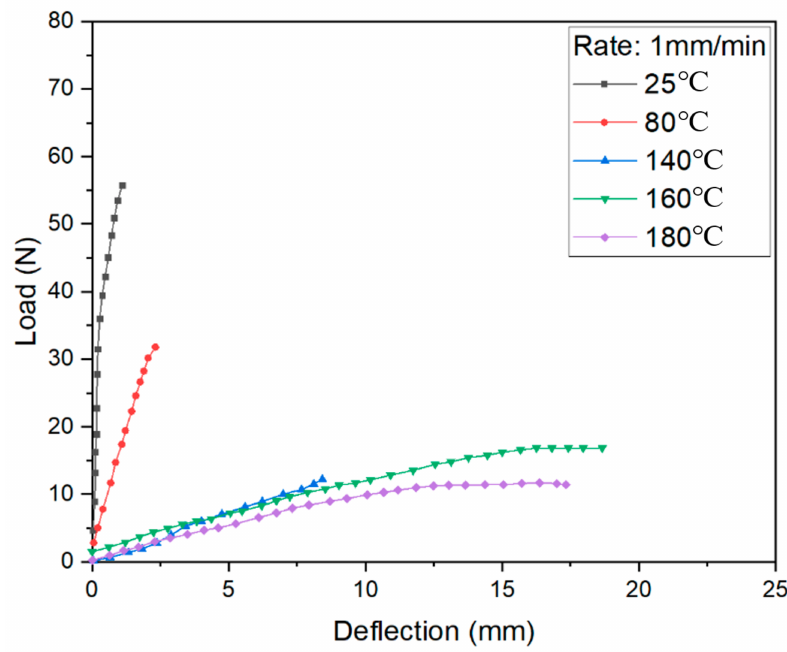
Figure 8. Load-displacement curves and fitting surface under 1 mm/min loading